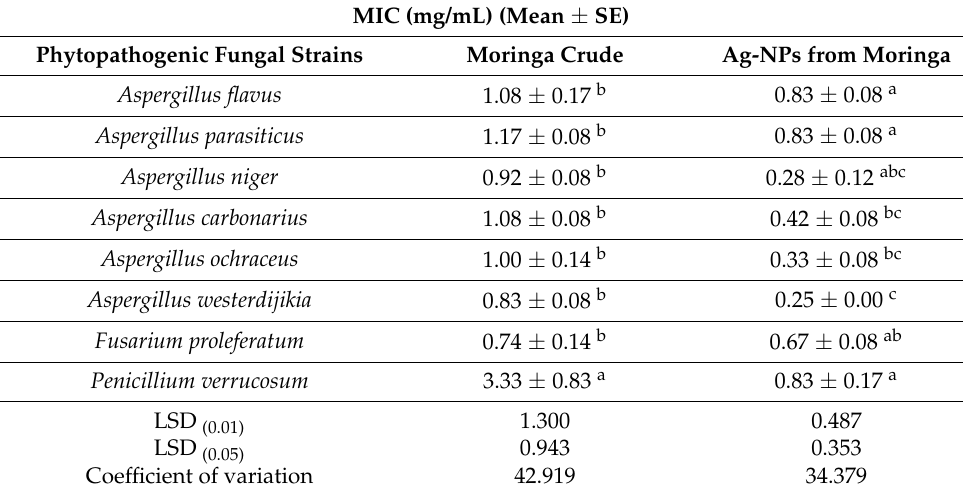
Table 11. The minimum inhibitory concentration of Moringa crude aqueous extracts and synthesized Ag-NPs against different fungal